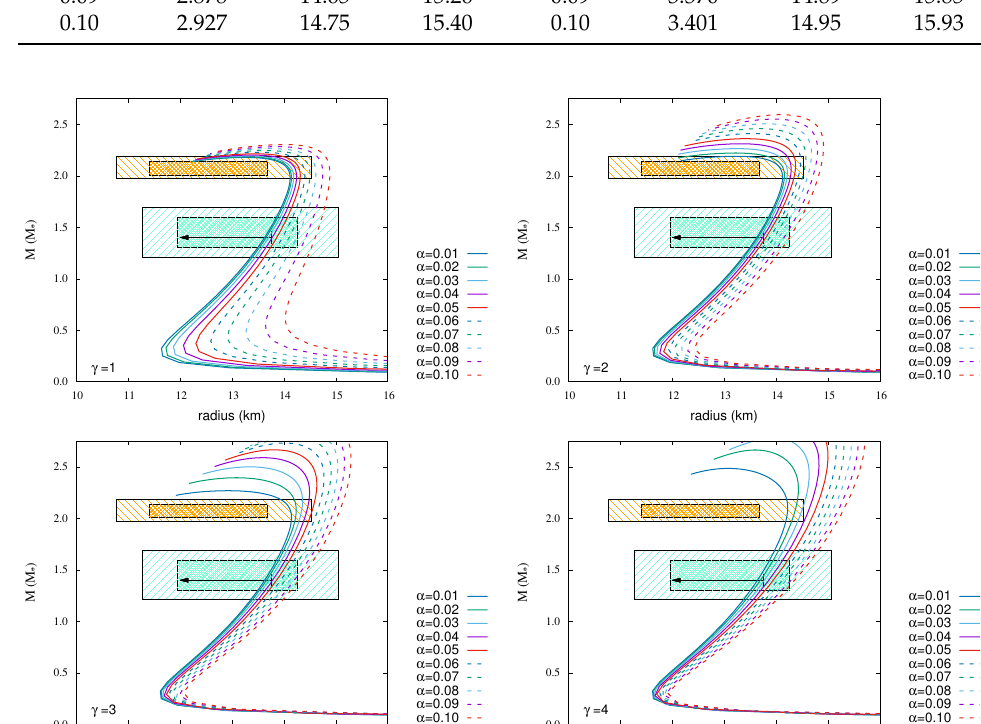
Figure 6. MR relations of NL3 ωρ -a EoS with magnetic fields. The strength of surface magnetic field strength B s is 10 12 G, and the central magnetic field strength B 0 is 2.5 × 10 18 G. The arrow and colored hatched areas are the same as in Figure